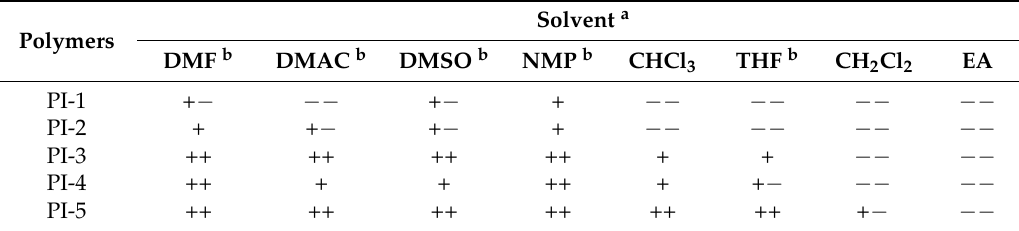
Table 2. Solubility of